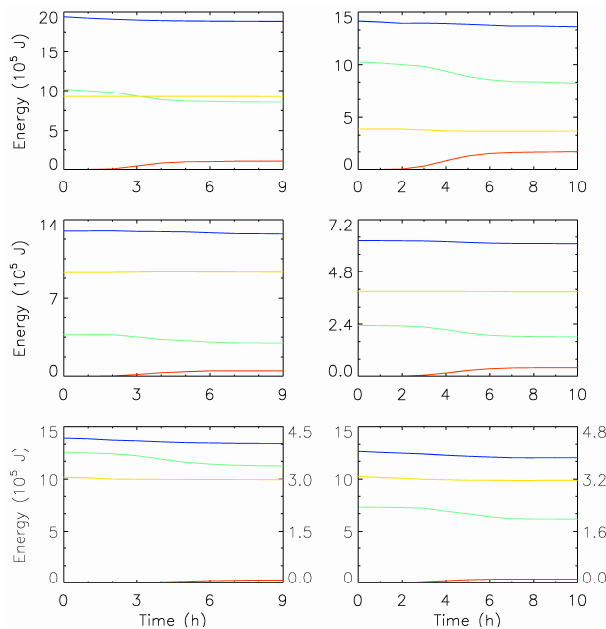
Fig. 6. Similar to Fig. 3, but for cases 4–6 (left columns) and cases Figure 6. Similar to Fig. 3, but for cases 4-6 (left columns) and cases 7-9 (right columns). The green, 7–9 (right columns). The green, yellow and red lines denote ener- gies of the primary, secondary and excited waves, respectively; and yellow and red lines denote energies of the primary, secondary and excited waves, respectively; and the blue the blue line denotes their total line denotes their total energy.